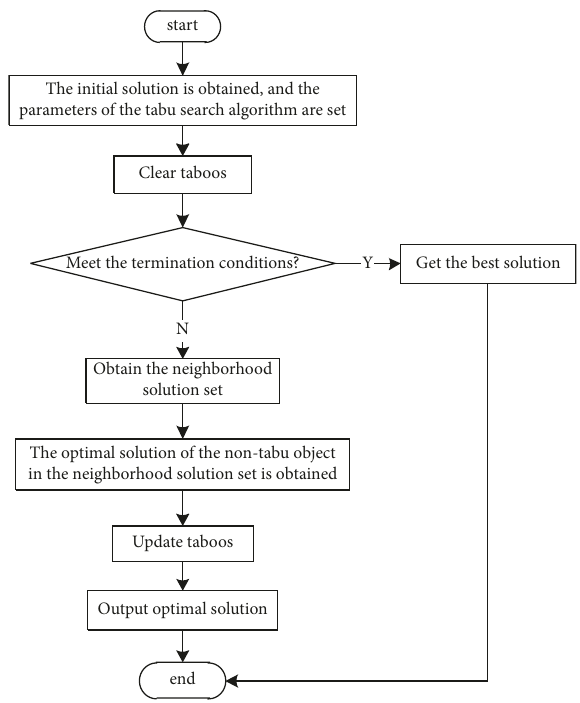
Figure 1: Basic flow of tabu search